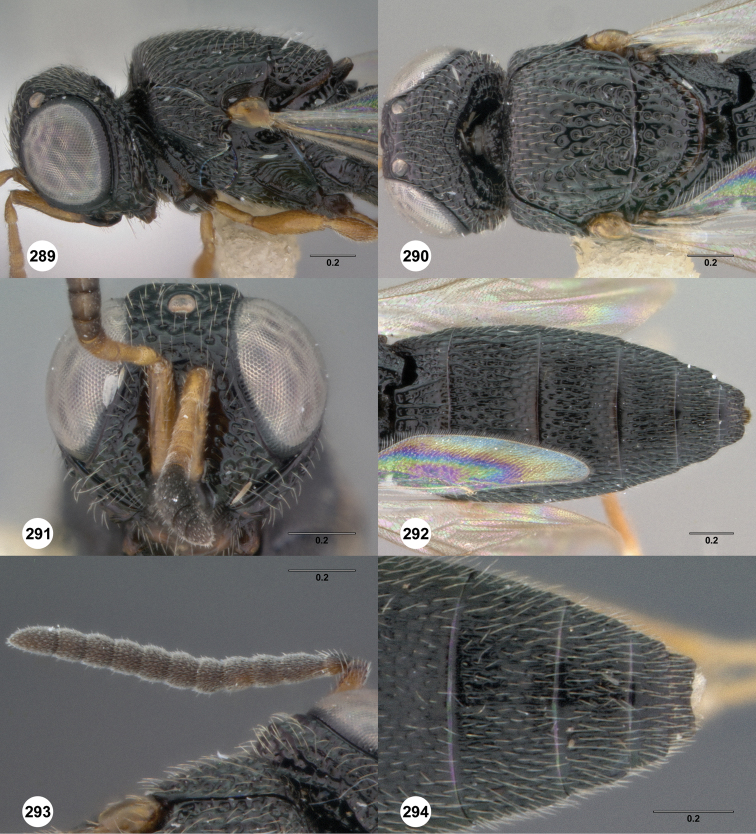
Oxyscelio rupturae sp. n., holotype female (OSUC 268197) 289 Head and mesosoma, lateral view 290 Head and mesosoma, dorsal view 291 Head, anterior view 292 Metasoma, dorsal view. Paratype male (OSUC 268190) 293 Antenna 294 Metasoma, dorsal view. Morphbank83